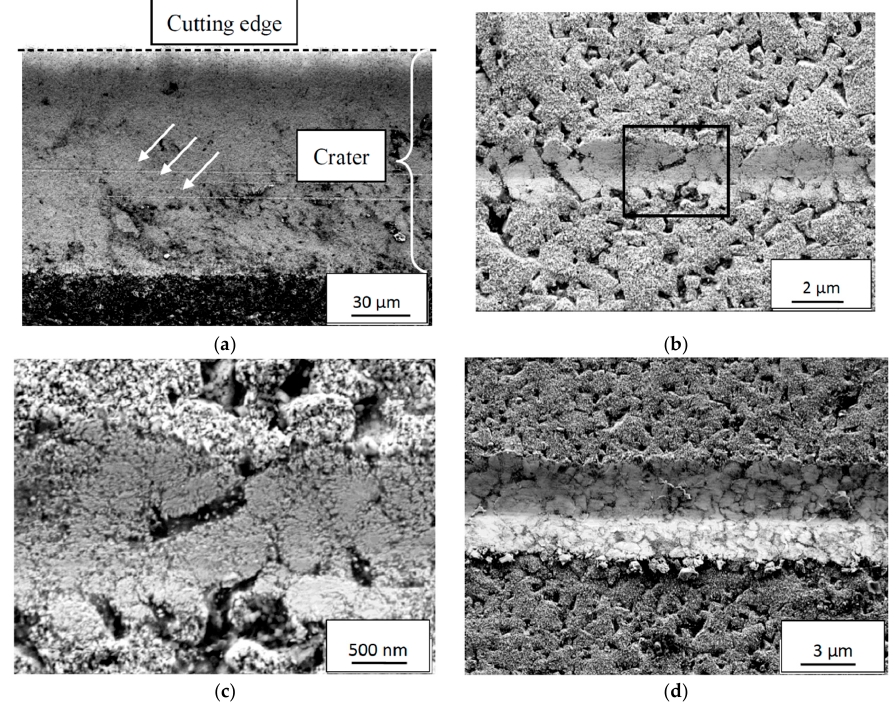
Figure 21. SEM images from the crater area of an etched insert illustrating the scratching characteristics of the WC 1 − x layer. ( a ) Low magnification overview image showing three scratches within the crater. ( b ) and ( c ) Scratching response at a normal load of 0.01 N; ( d ) Scratching response at a load of 0.05